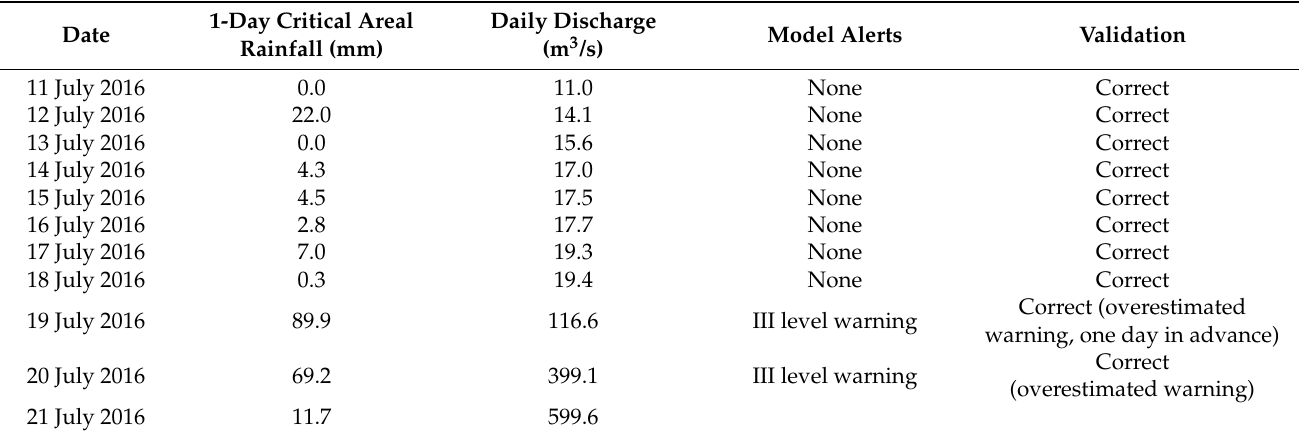
Table 5. Validation of the 2016 July flood warning in the Zhulong river